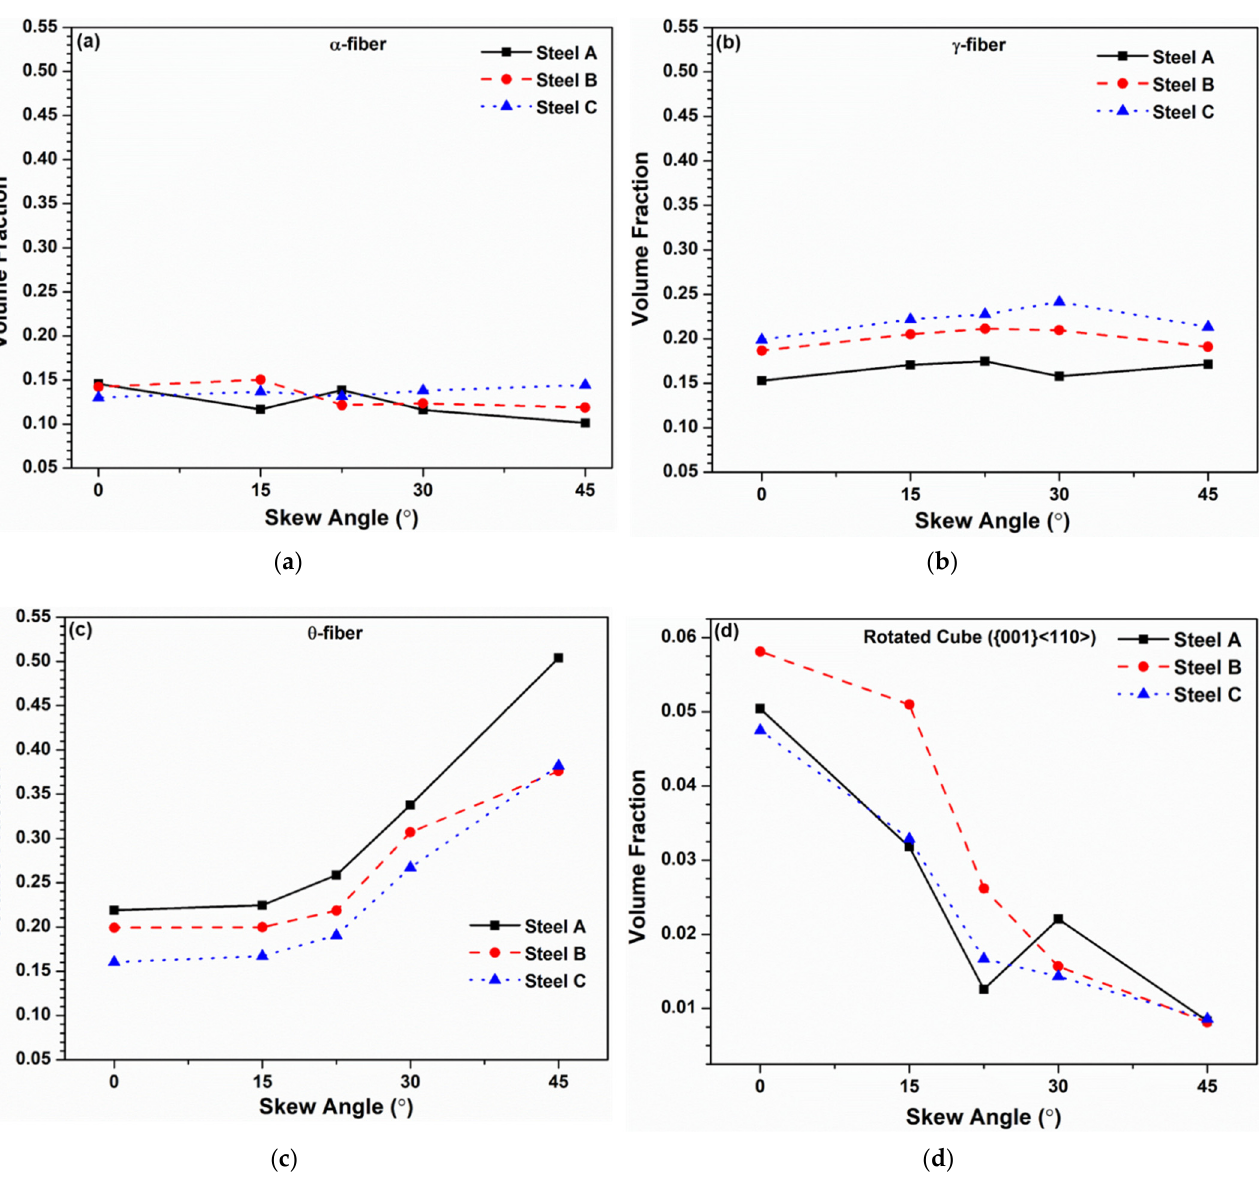
Figure 6. Textures after skew cold rolling with bidirectional feeding [26]: ( a ) Steel A, ( b ) Steel B and ( c ) Steel C.